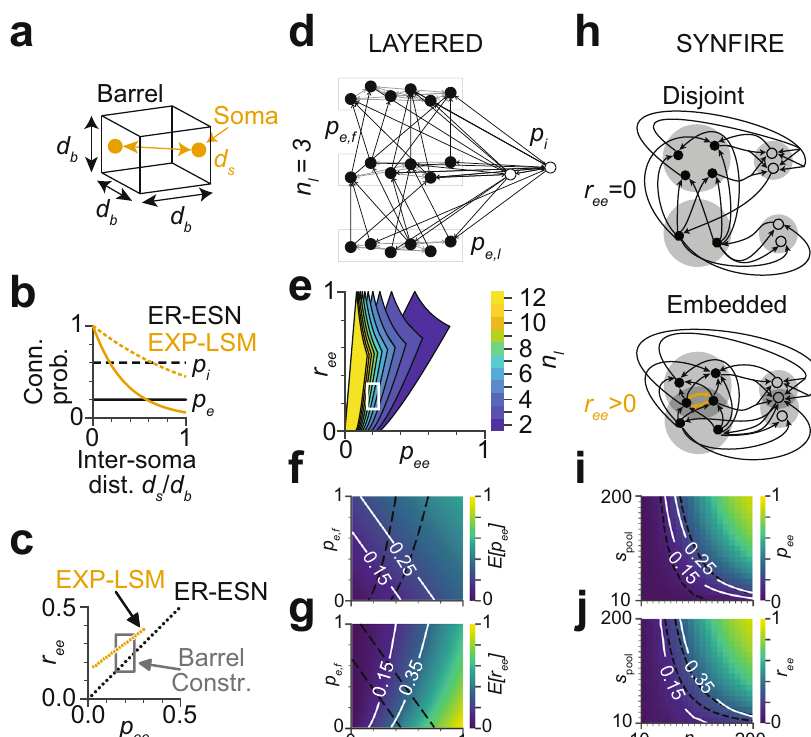
Fig. 2 Compliance of candidate models with the so-far experimentally determined pairwise barrel circuit constraints in L4 (see Fig. 1d). a Illustration of a simpli fi ed cortical barrel of width d b and somata with inter soma distance d s . b Pairwise excitatory and inhibitory connection probabilities p e and p i are constant over inter soma distance d s in the Erd ő s – Rényi echo state network (ER-ESN) and decay in the exponentially decaying connectivity - liquid state machine model (EXP-LSM). c Possible pairwise excitatory-excitatory connectivity p ee and excitatory-excitatory reciprocity r ee in the ER-ESN and EXP-LSM model satisfy the so-far determined barrel constraints (box). d – g Layered model: d example network with three layers ( n l ¼ 3), excitatory